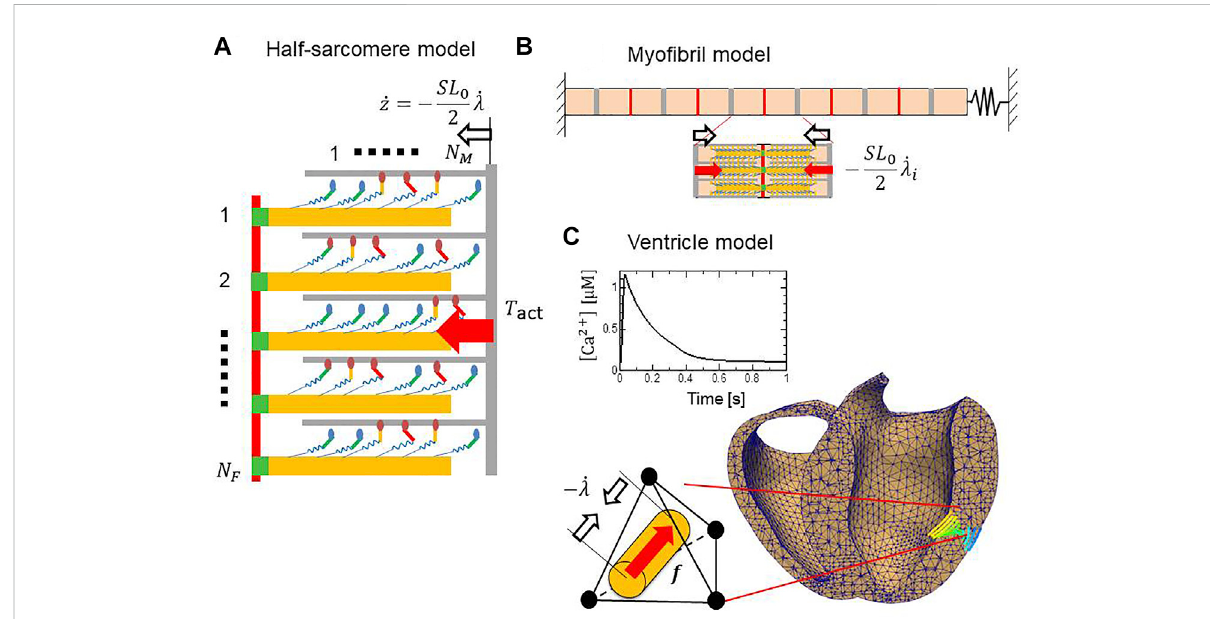
FIGURE 4 Computational models at three scales. (A) A half-sarcomere model consisting of N F fi lament pairs. In the stretch activation test, a rapid length change was imposed after the isometric force had matured. (B) The myo fi bril model for the SPOC simulation. The half-sarcomere models were imbeddedtocomputetheactivetensionsinindividualhalf-sarcomeres,whereastheirstretchesprovidefeedbacktothehalf-sarcomere models. (C) A cross-section of the fi nite element bi-ventricular model and the transmural change in fi ber orientation. The half-sarcomere models were imbedded in tetrahedral elements to compute the contraction force in the fi ber direction, whereas the stretches in the fi ber direction provided feedback to the half-sarcomere models. The boxed inset shows the Ca 2+ transient given in each